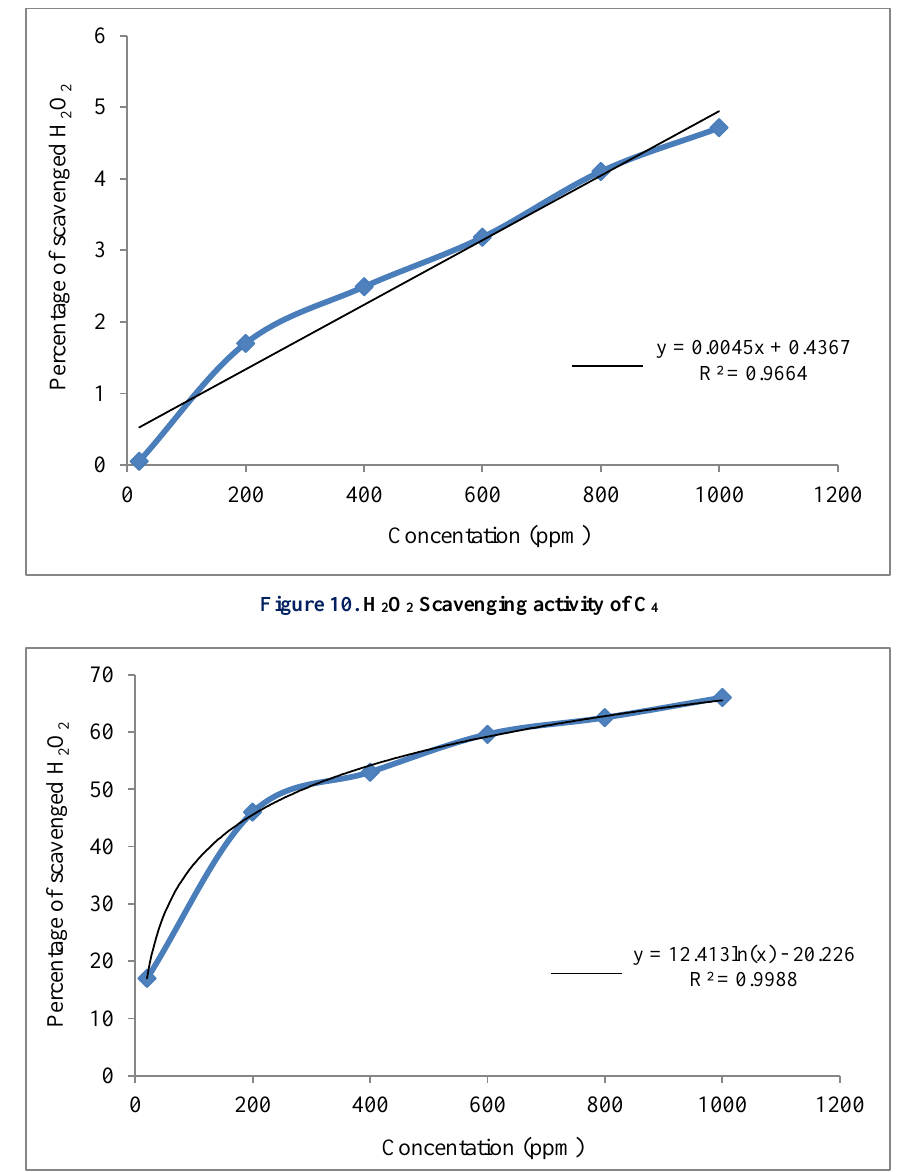
Figure 11. H 2 O 2 Scavenging activity of Ascorbic acid